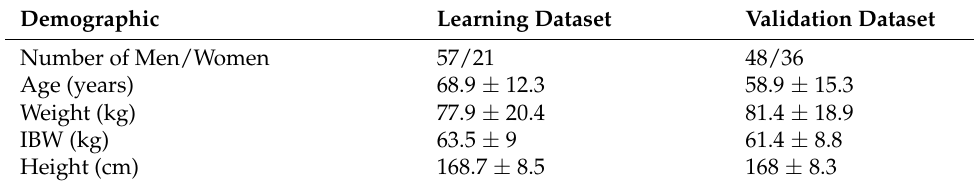
Table 1. Baseline characteristics of